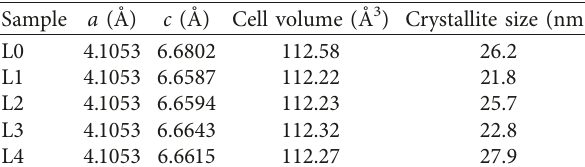
Table 1: Cell parameters of CdS:Cu thin films obtained by XRD.